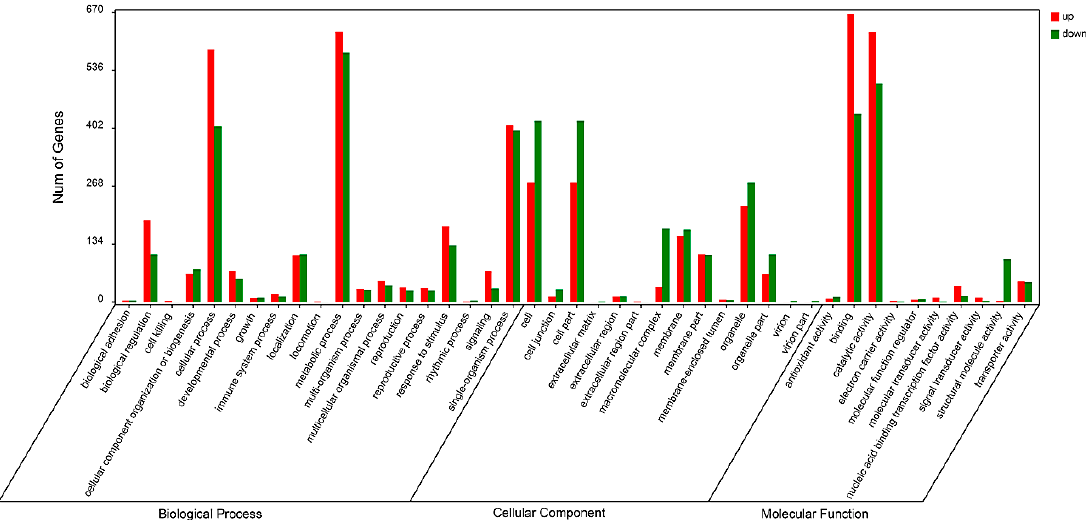
Figure 3. GO classification of differentially expressed genes.